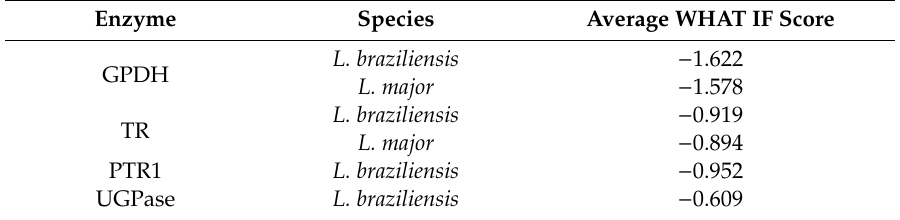
Table 6. Average scores for each residue, obtained from the WHAT IF server, for each